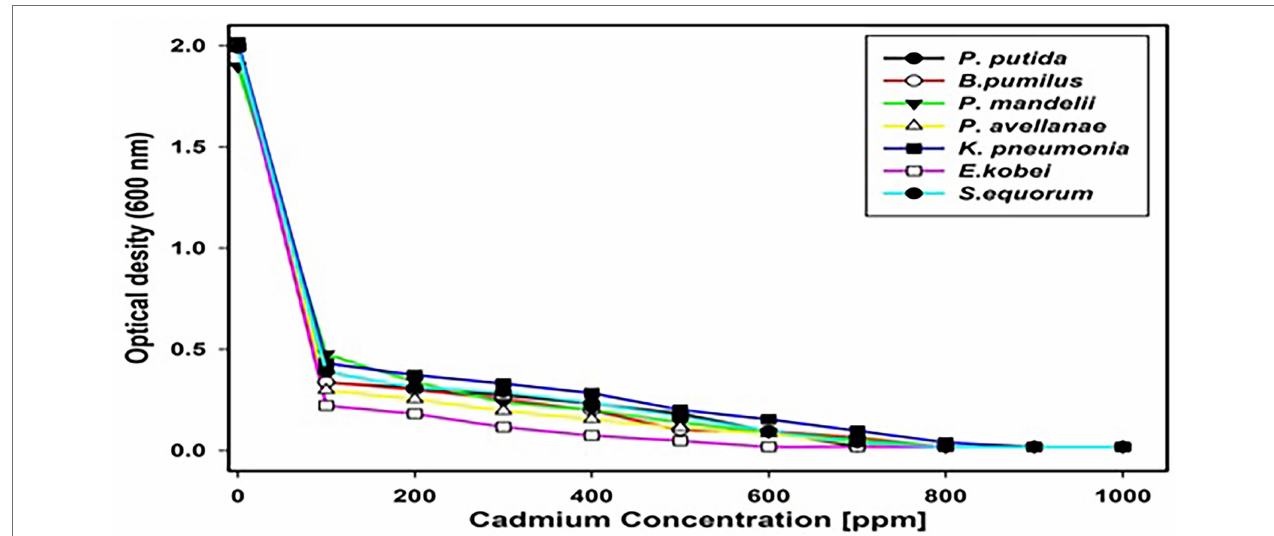
FIGURE 5 | Optical Density (OD) values indicating minimum inhibitory concentrations (MICs) of isolates resistant to